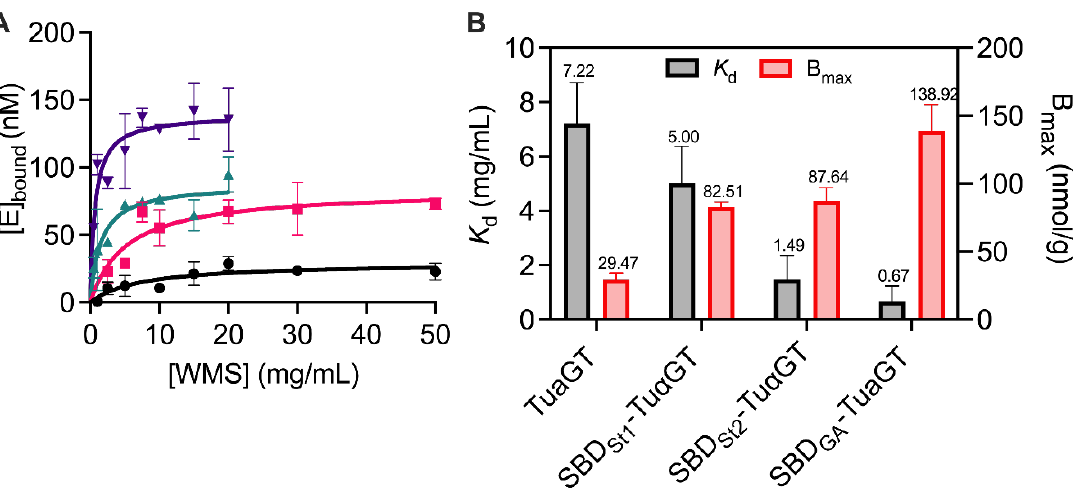
Figure 4. Binding capacity of Tu α GT and SBD-Tu α GT fusions on waxy maize starch (WMS) granules. ( A ) Binding isotherms on WMS granules for Tu α GT (black), SBD St1 -Tu α GT (red), SBD St2 -Tu α GT (green), and SBD GA -Tu α GT (purple) at 25 ◦ C and pH 7.0. Lines represent best fits of the Langmuir adsorption isotherm. ( B ) Dissociation constant ( K d ) and (apparent) saturation coverage (B max ) on WMS granules.